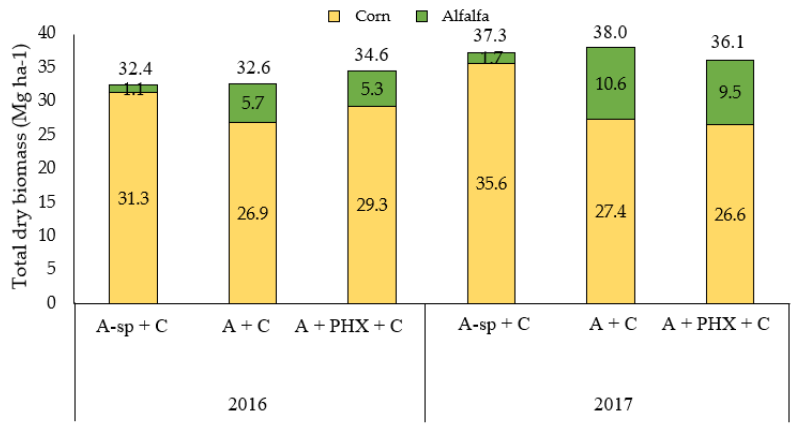
Figure 4. Second-order polynomial regression of alfalfa yield (Mg ha −1 ) against ( A ) alfalfa stem density (no. m −2 ) and ( B ) alfalfa stem height (cm), at each harvest in the seeding year of both experiments in studies started in 2016 and 2017 at Boone, IA, USA.